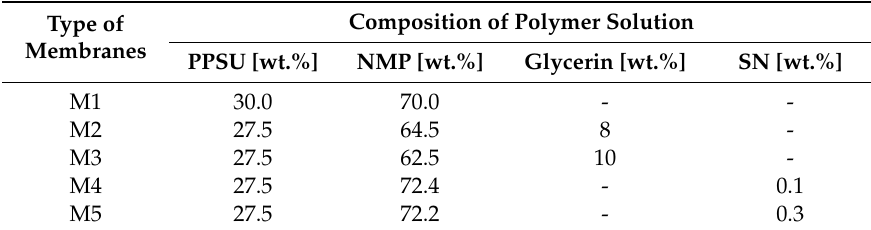
Table 1. Composition of the polyphenylsulfone (PPSU) based membranes. Composition of Polymer Solution Type of Membranes PPSU [wt.%] NMP [wt.%] Glycerin